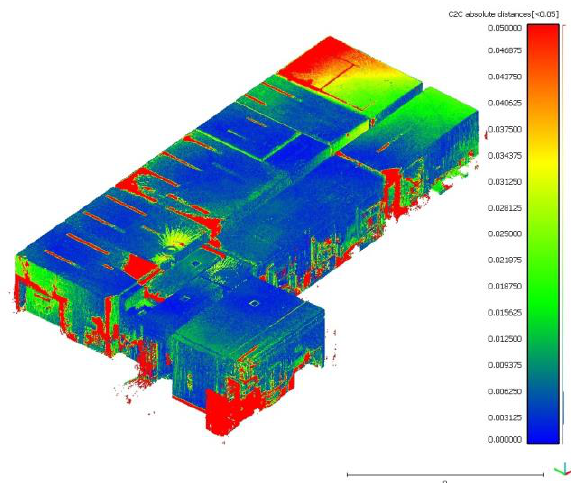
Figure 3 . Cloud-to-cloud comparison of the 2 nd basement of the test object n. 2.